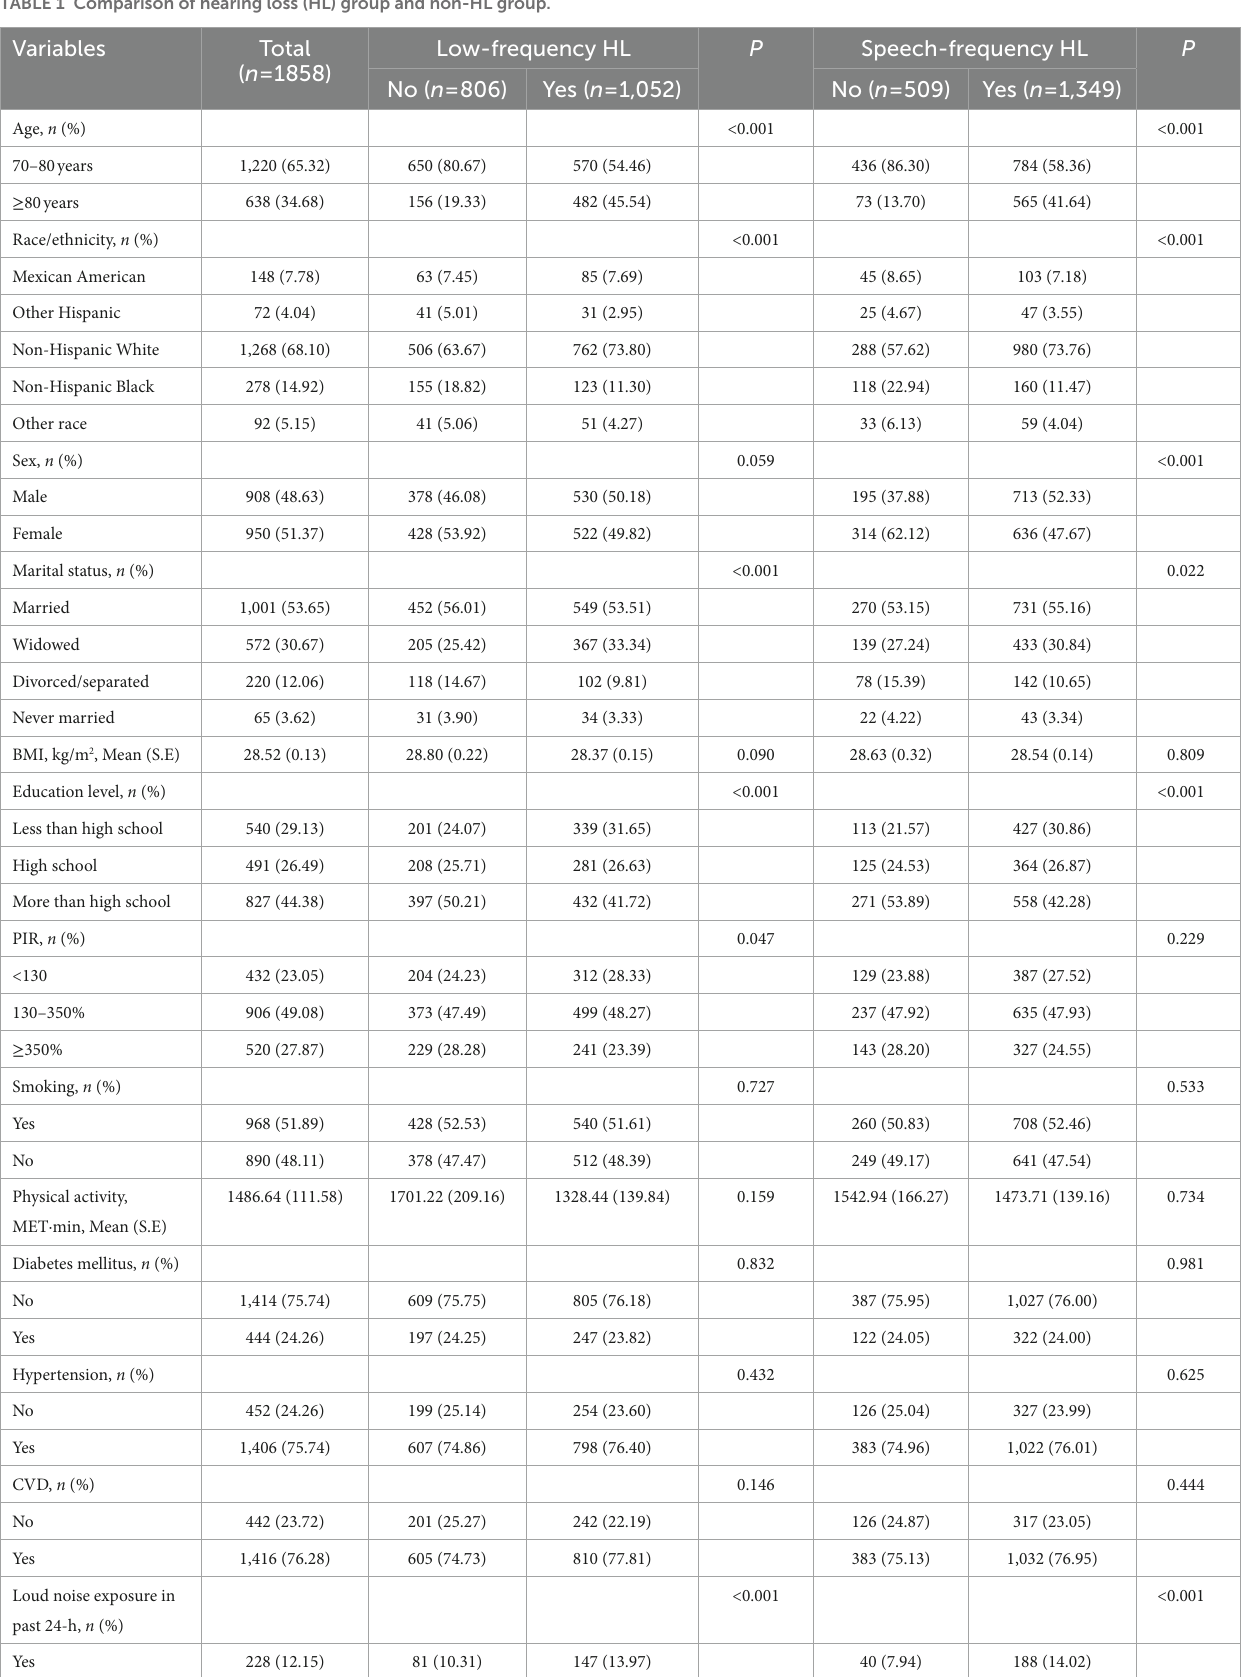
TABLE 1 Comparison of hearing loss (HL) group and non-HL